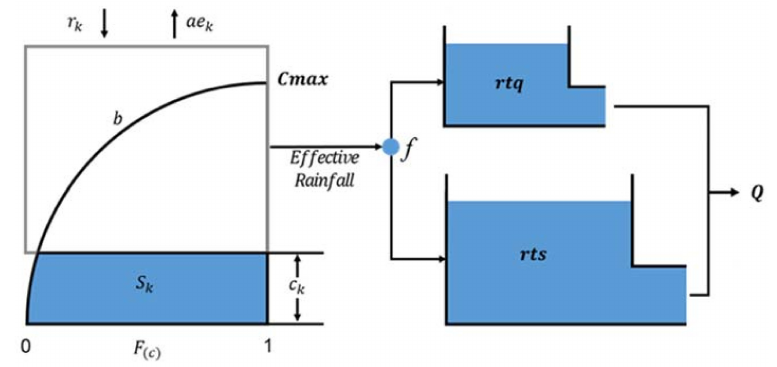
Figure 4. Schematic description of the PDM model [28].